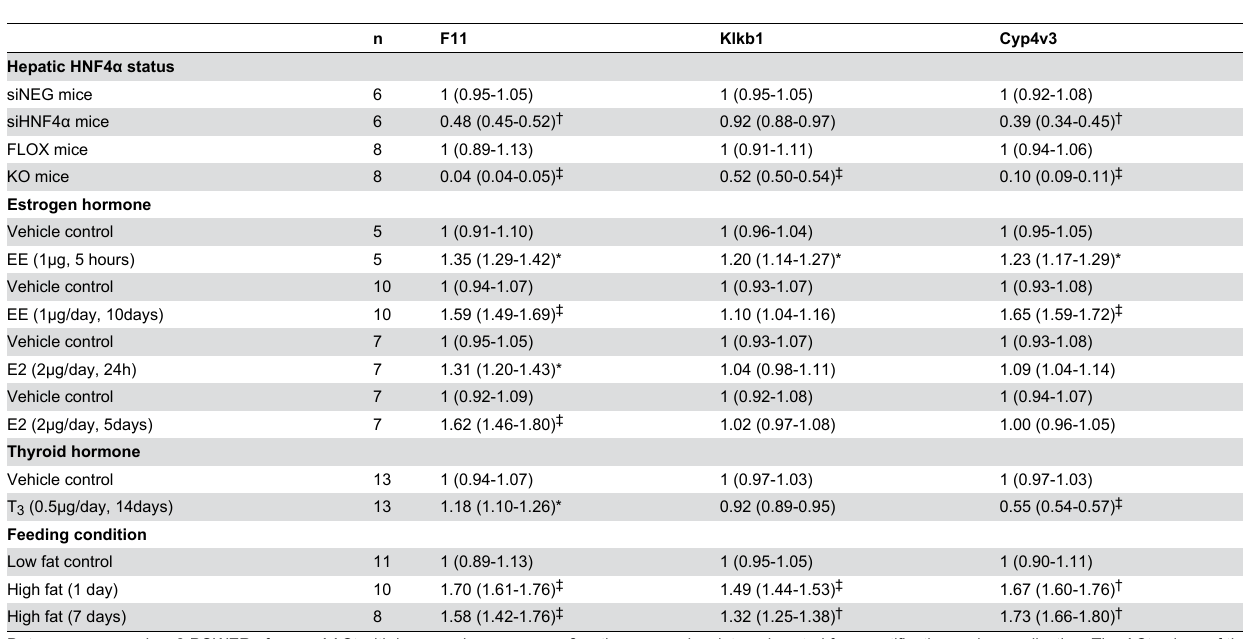
Table 1. Transcript levels of F11 , Klkb1 and Cyp4v3 in livers of challenged